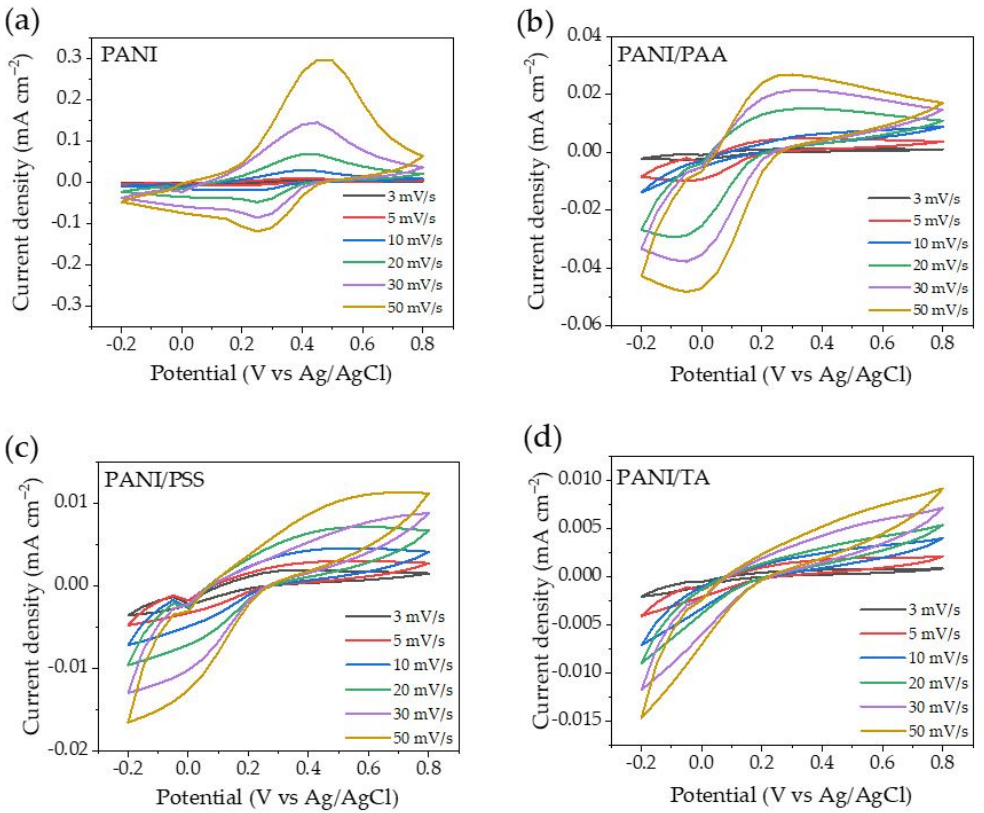
Figure 6. ( a ) Cyclic voltammograms of PANI, ( b ) PANI/PAA, ( c ) PANI/PSS, and ( d ) PANI/TA LbL films at different scan rates in 1 M Na 2 SO 4 electrolyte (vs. Ag/AgCl reference electrode).